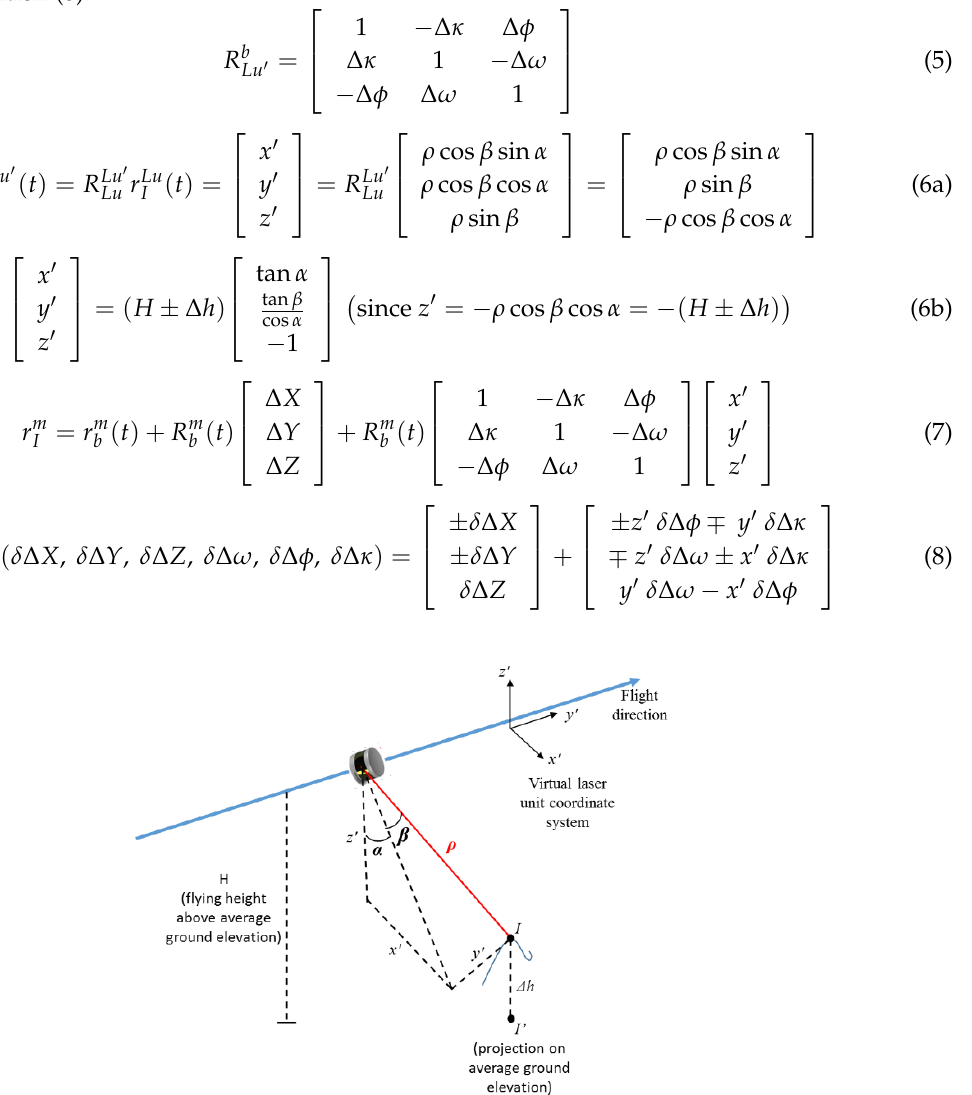
Figure 6. Schematic diagram illustrating the symbolic notations used for a UAV-based LiDAR system calibration.